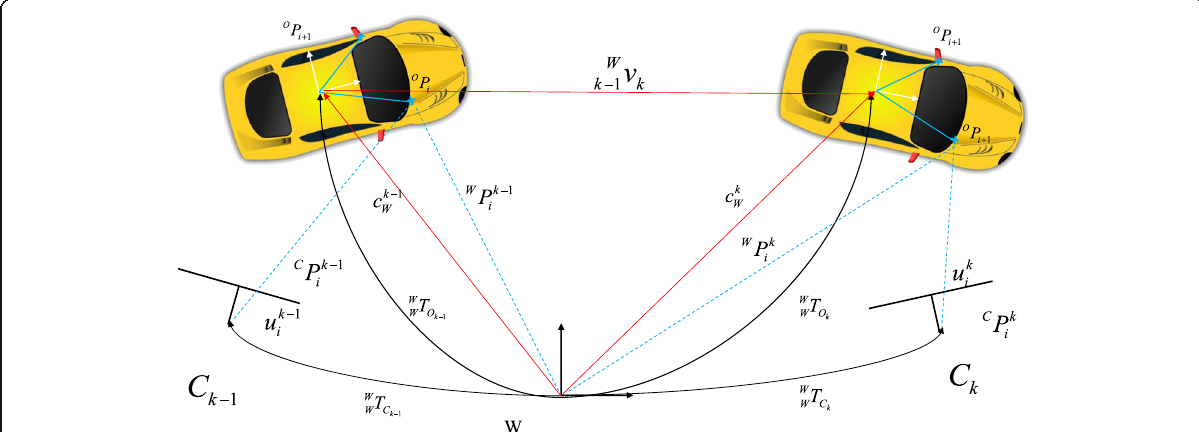
Fig. 2 Model for a dynamic camera and dynamic object. The camera observes the same dynamic car at timestamps k − 1 and k . Here, the black solid curves represent camera ( W W T c ) and object poses ( W W T o ) in the world frame. Red solid lines represent the position and the speed of dynamic object in the world frame. Blue dashed lines represent 3D points in camera frames or the world